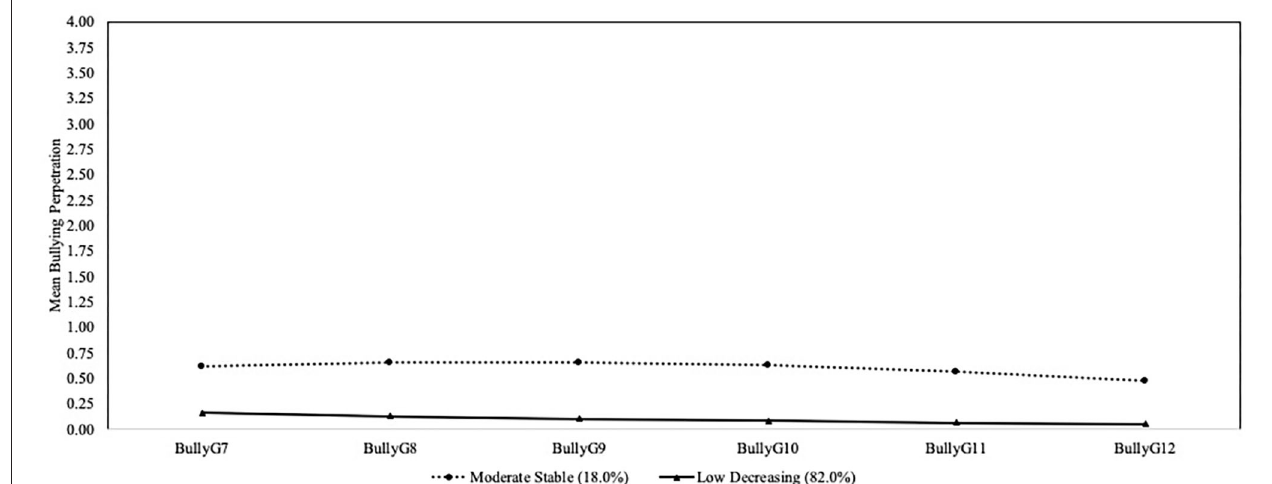
FIGURE 1 | Developmental trajectories of bullying perpetration. Bully, bullying perpetration; G, grade.